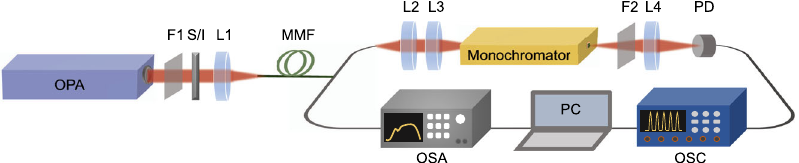
Fig. 2 Schematic illustration of the experimental setup for SC generation and intensity noise measurement. OPA optical parametric ampli fi er, L1 – L4 plano-convex lenses, F1 – F2 long-pass fi lters, S/I dichroic fi lter to select signal/idler, PD photodetector, MMF multimode fi ber, OSA , optical spectrum analyzer, OSC